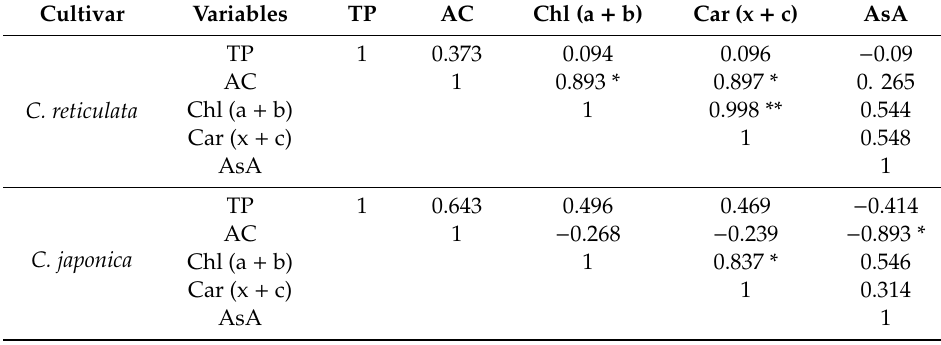
Table 1. Pearson correlations among bioactive compounds in the seeds (* p < 0.05; ** p < 0.01); total polyphenols—TP; antioxidant capacity—AC; total chlorophyll—Chl (a + b); total carotenoids— Car (x + c); ascorbic